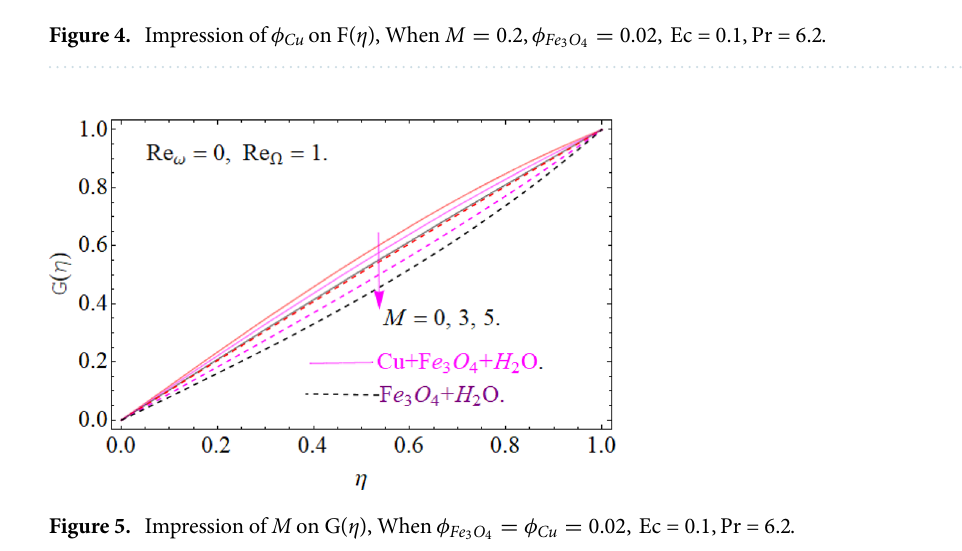
Figure 5. Impression of M on G( η ), When φ Fe 3 O 4 = φ Cu = 0.02, Ec = 0.1, Pr = 6.2 .